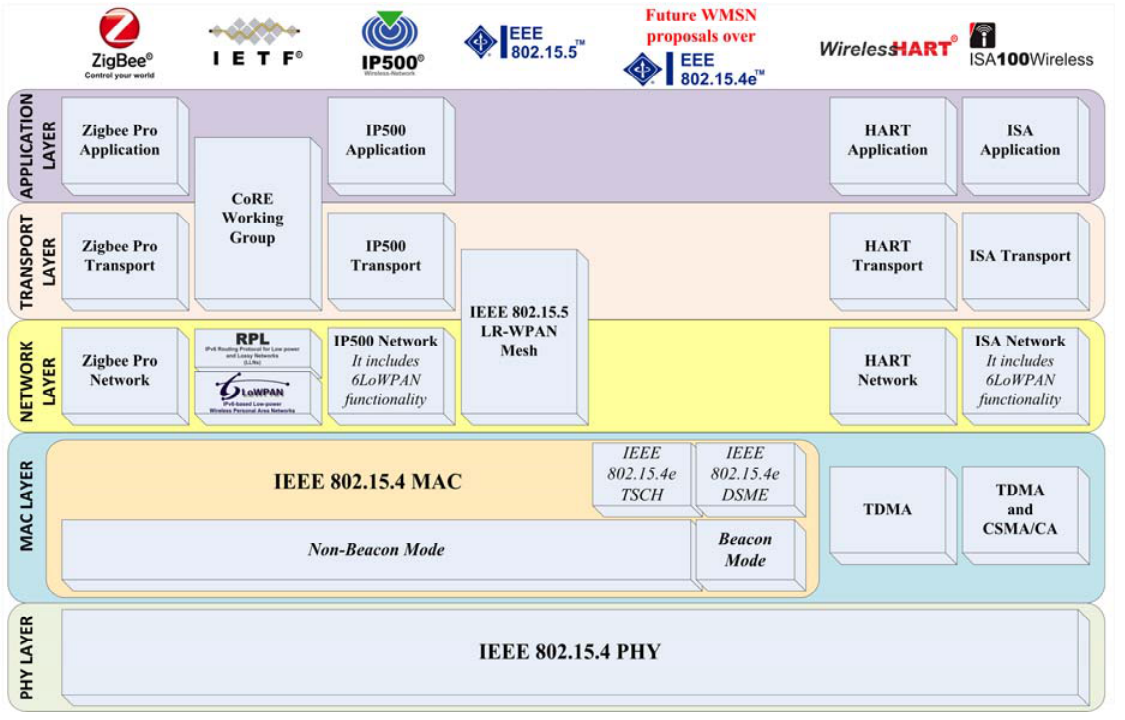
Figure 2. LR-WPAN architecture for the current wireless sensor approaches enabling mesh